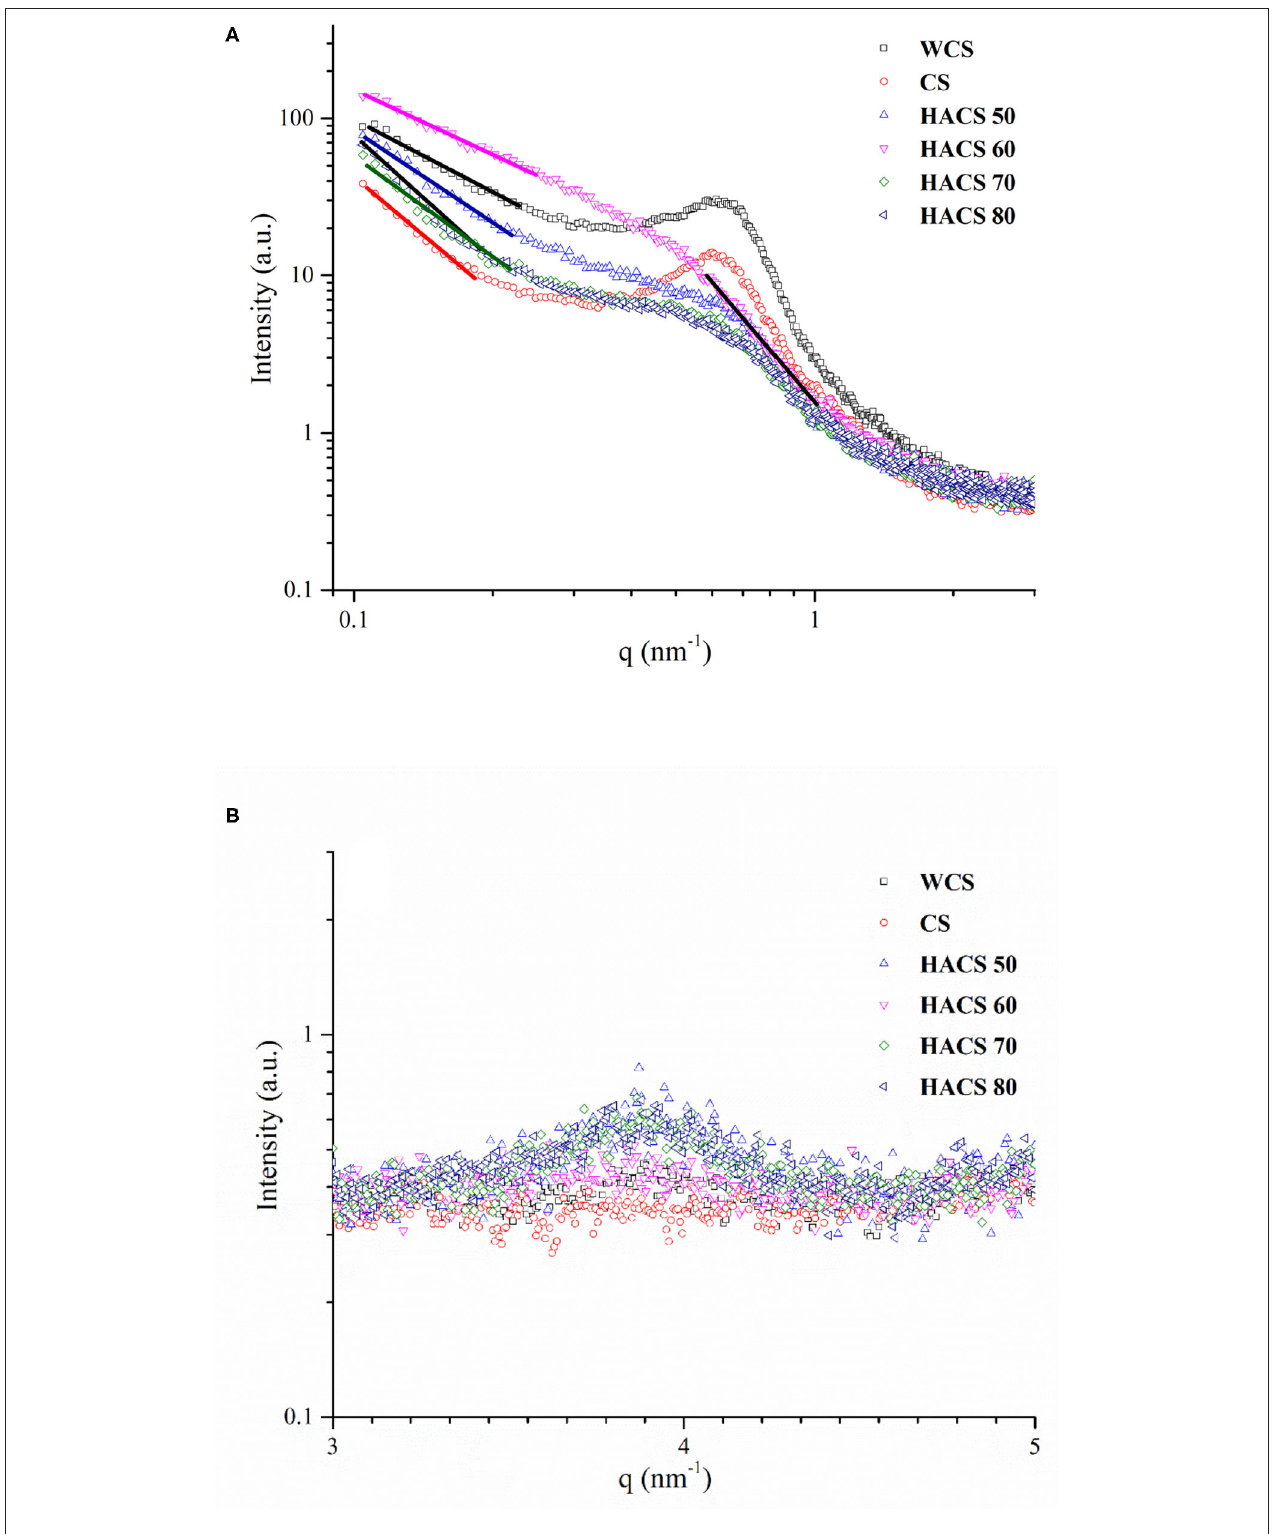
FIGURE 7 | Double-logarithmic SAXS patterns (A) , log I-q SAXS patterns (B) .